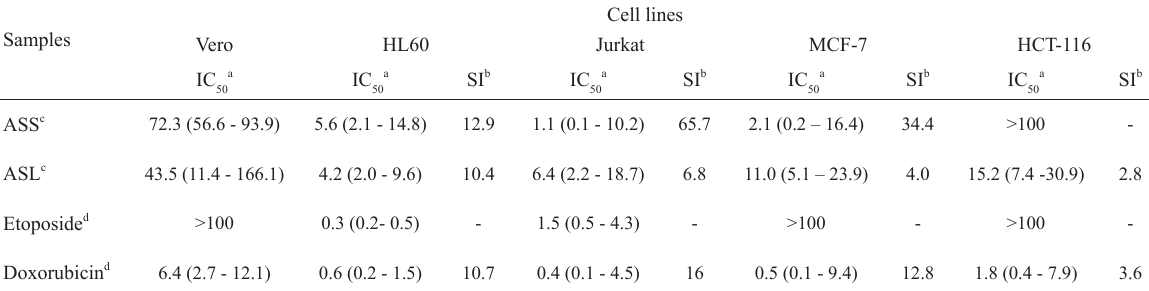
In vitro cytotoxicity and selectivity index of Annona squamosa extracts.